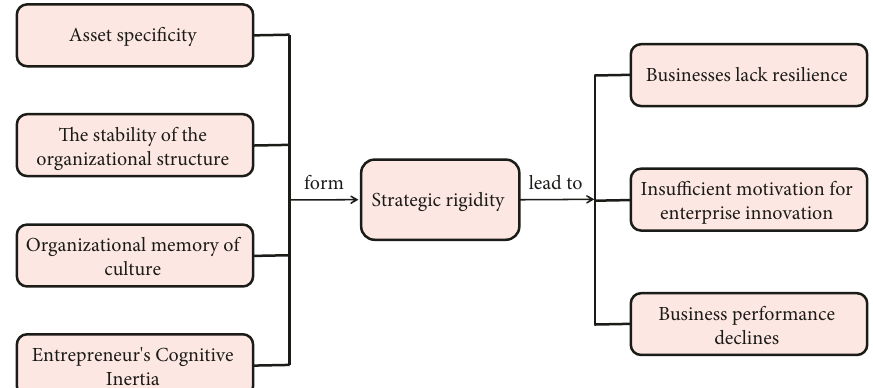
Figure 2: Process of negative effects of strategic rigidity on enterprises.